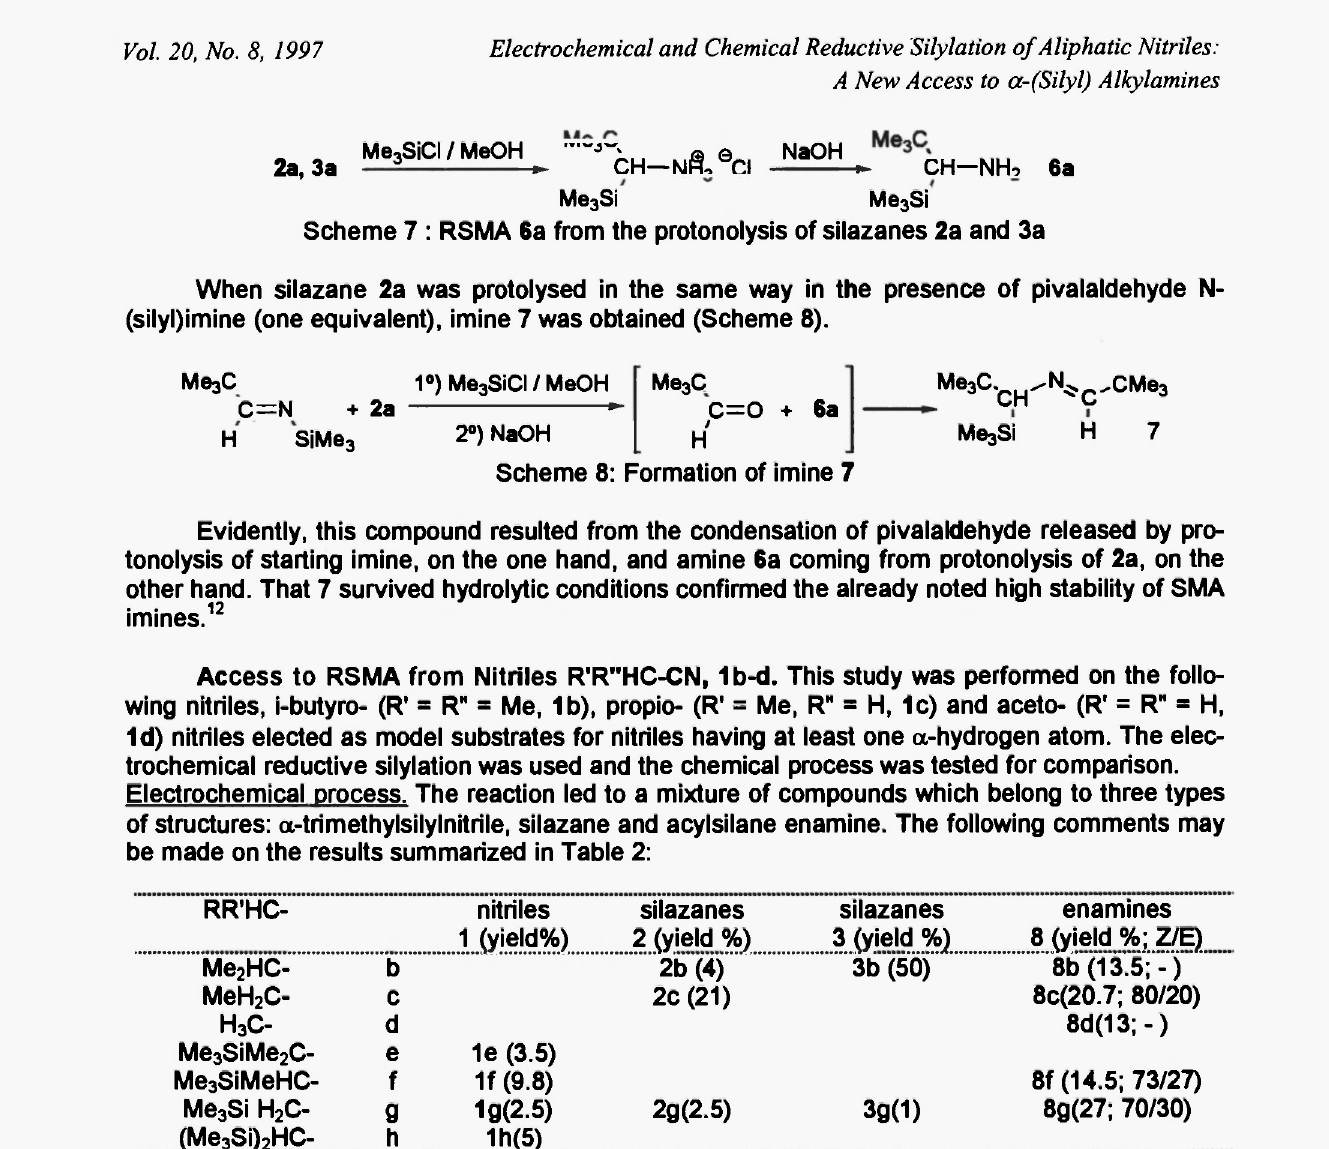
Table 2 : Electrochemical reductive silylation of nitriles 1b-d.